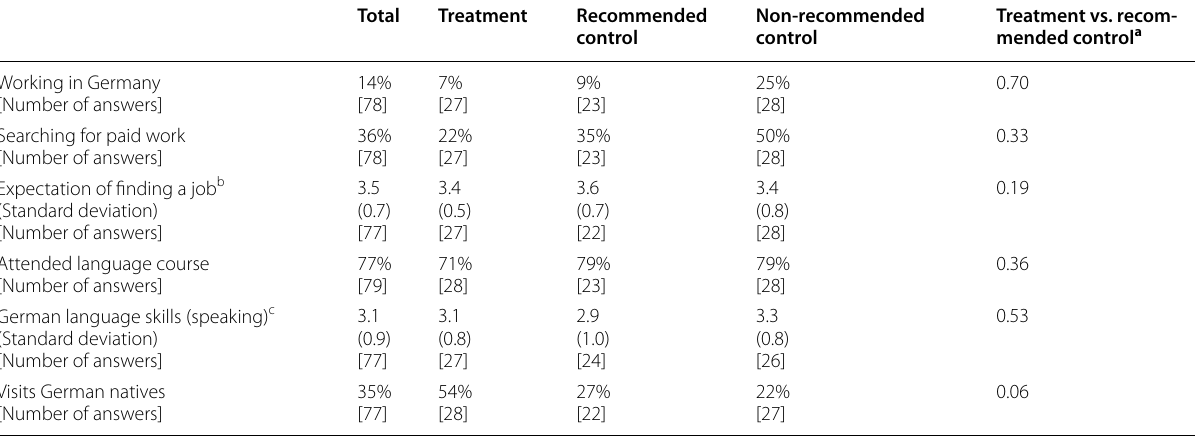
Source ZEW inclusive soccer project survey; own calculations